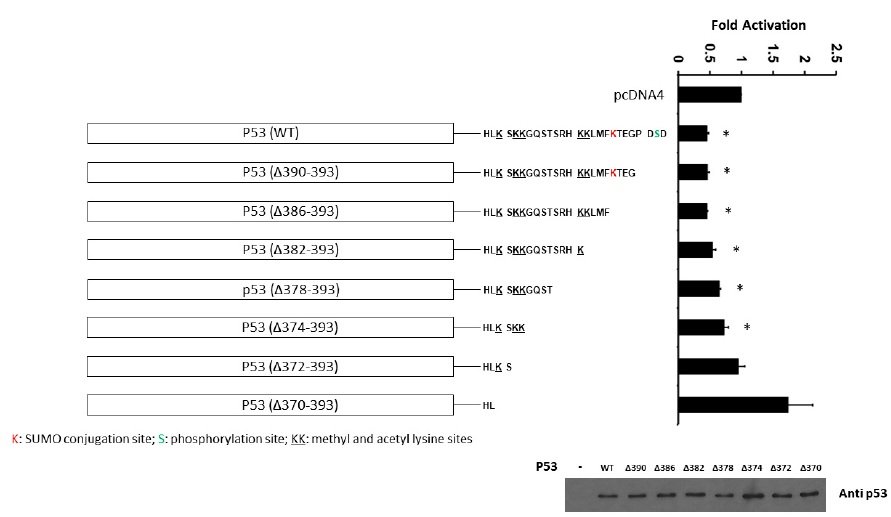
Figure 6. The C-terminal domain (between aa374 and aa370) of p53 is required for p53-mediated PDCD4 repression. H1299 cells in a 24-well plate were co-transfected with PDCD4 luciferase reporter plasmid and pRL-TK Renilla control vector, and various truncated p53 expression plasmids by Fugene HD. After forty-eight hours of transfection, luciferase activities were analyzed by the Dual-Luciferase Reporter System and normalized to the control Renilla activity. Relative LUC activity was calculated and plotted. p53 protein levels in the cells from the reporter assays were confirmed using anti-p53 immunoblotting. * indicates a p -value < 0.05 compared with pcDNA4 (control). The original WB can be found in Supplementary Material.